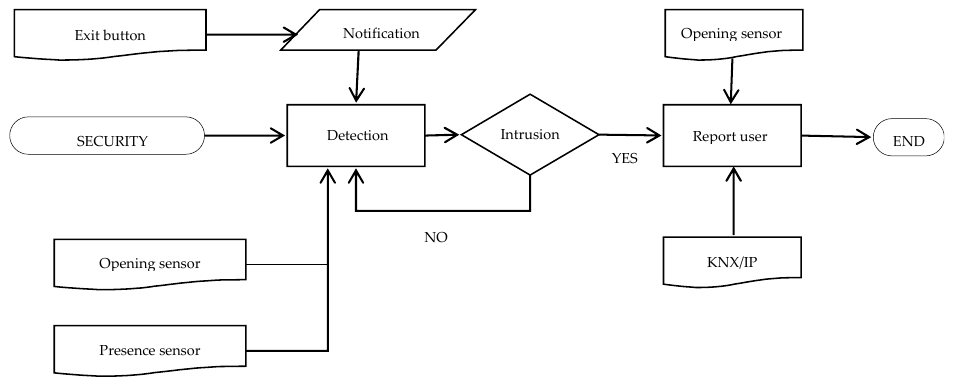
Figure 5. Security subsystem functioning flow chart. Table 12. Elements of security subsystem in common with the other systems.